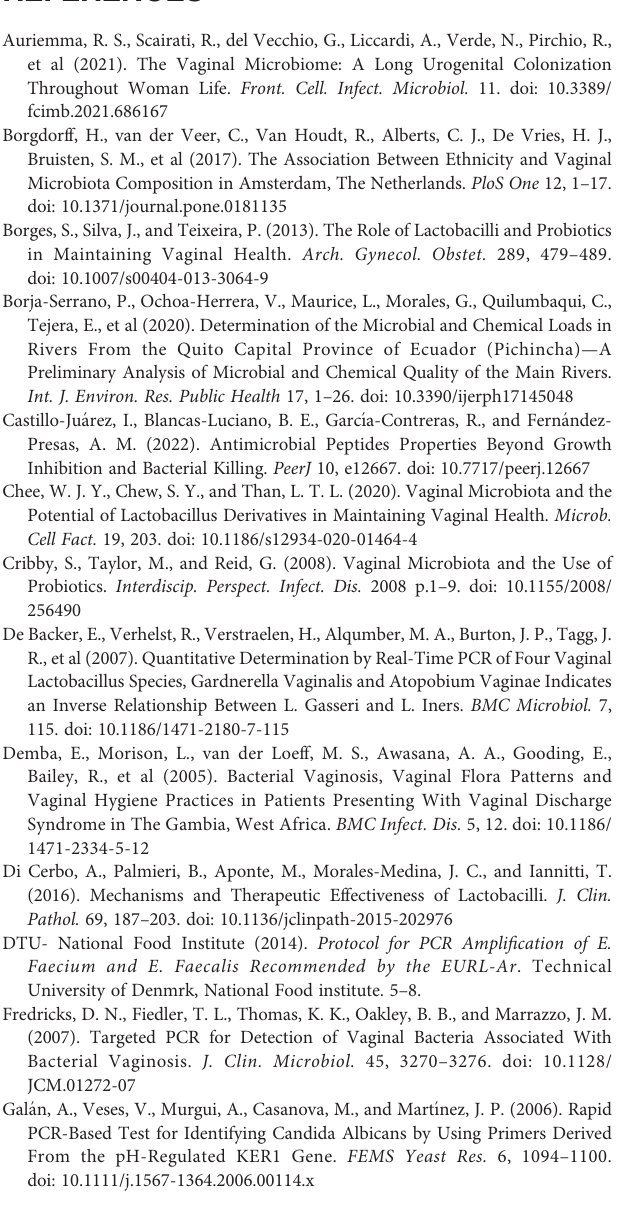
Supplementary Table 1 | PCR primers used in this study. Supplementary Table 2 | Evaluation of potential associations between the presence of Lactobacillus sp. and opportunistic pathogens. Multiple chi-square tests wereperformed to evaluate the absence or presence ofeach pathogen during the presence of each Lactobacillus sp., showing the P -values with statistically signi fi cant differences as bold values.